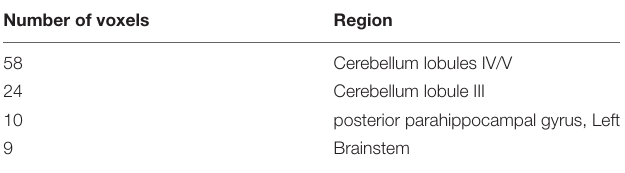
from the analysis. Handedness, race, and ethnicity were roughly balanced across participant groups ( Supplementary Table 1